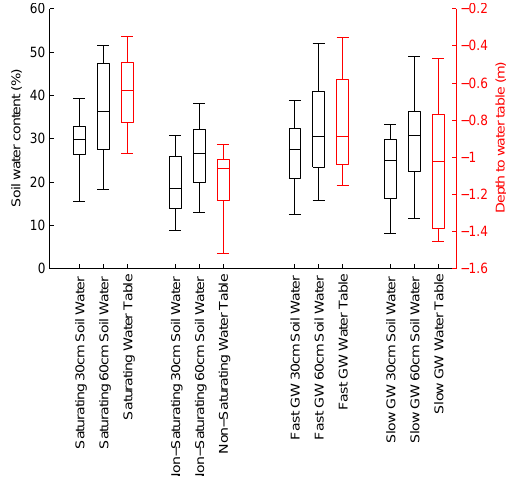
Figure 10. Distributions of soil moisture and depth to water table, classified as saturating/non-saturating sites, and fast/slow ground- water response sites. Saturating sites were defined as those where the water table rose as high as the 30cm soil moisture probe at any point during the study period. Fast/slow sites were classified accord- ing to the rate of groundwater response as described in Sect. 4.4.2 and Fig.